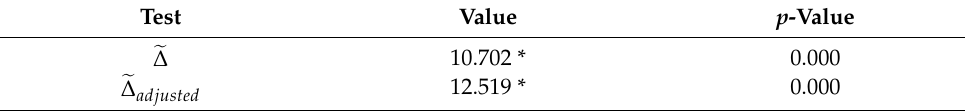
Table 5. Testing for slope heterogeneity.